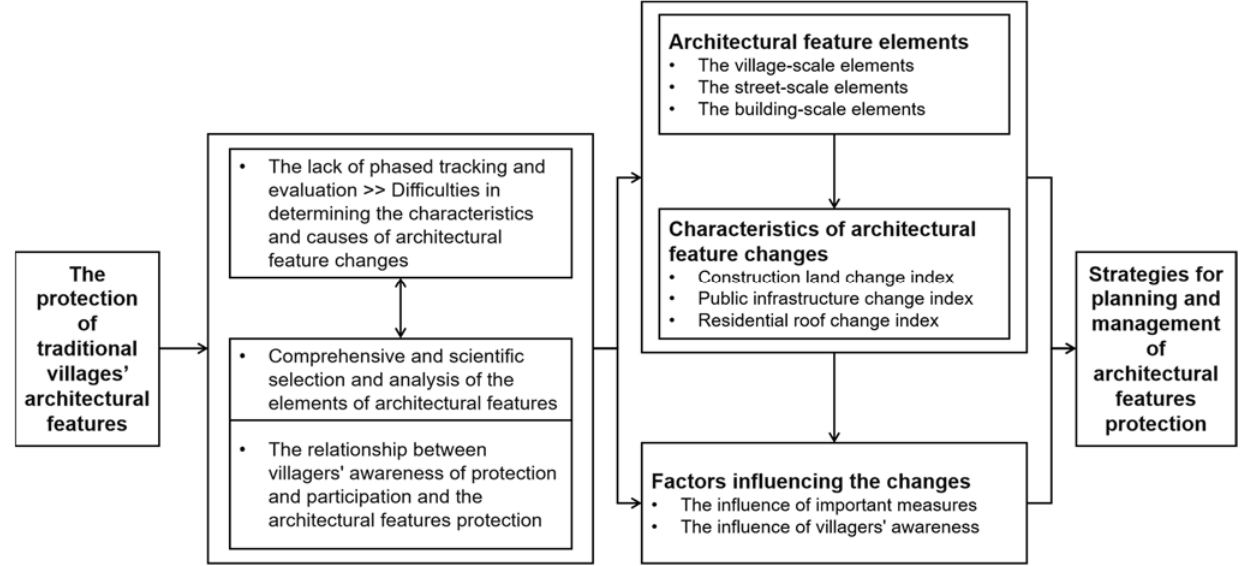
Figure 1. Analytical framework (Source: authors).